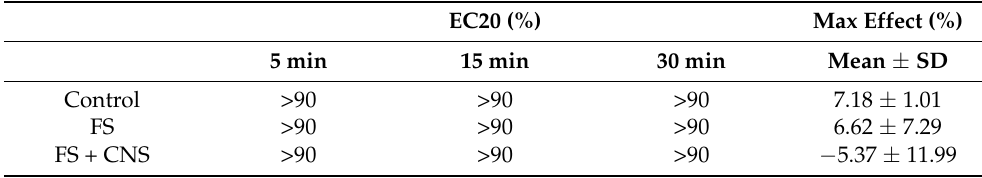
Table 2. EC20 values after 5, 15, and 30 min of incubation and maximum effect percentage (mean ± SD) at the highest concentration of